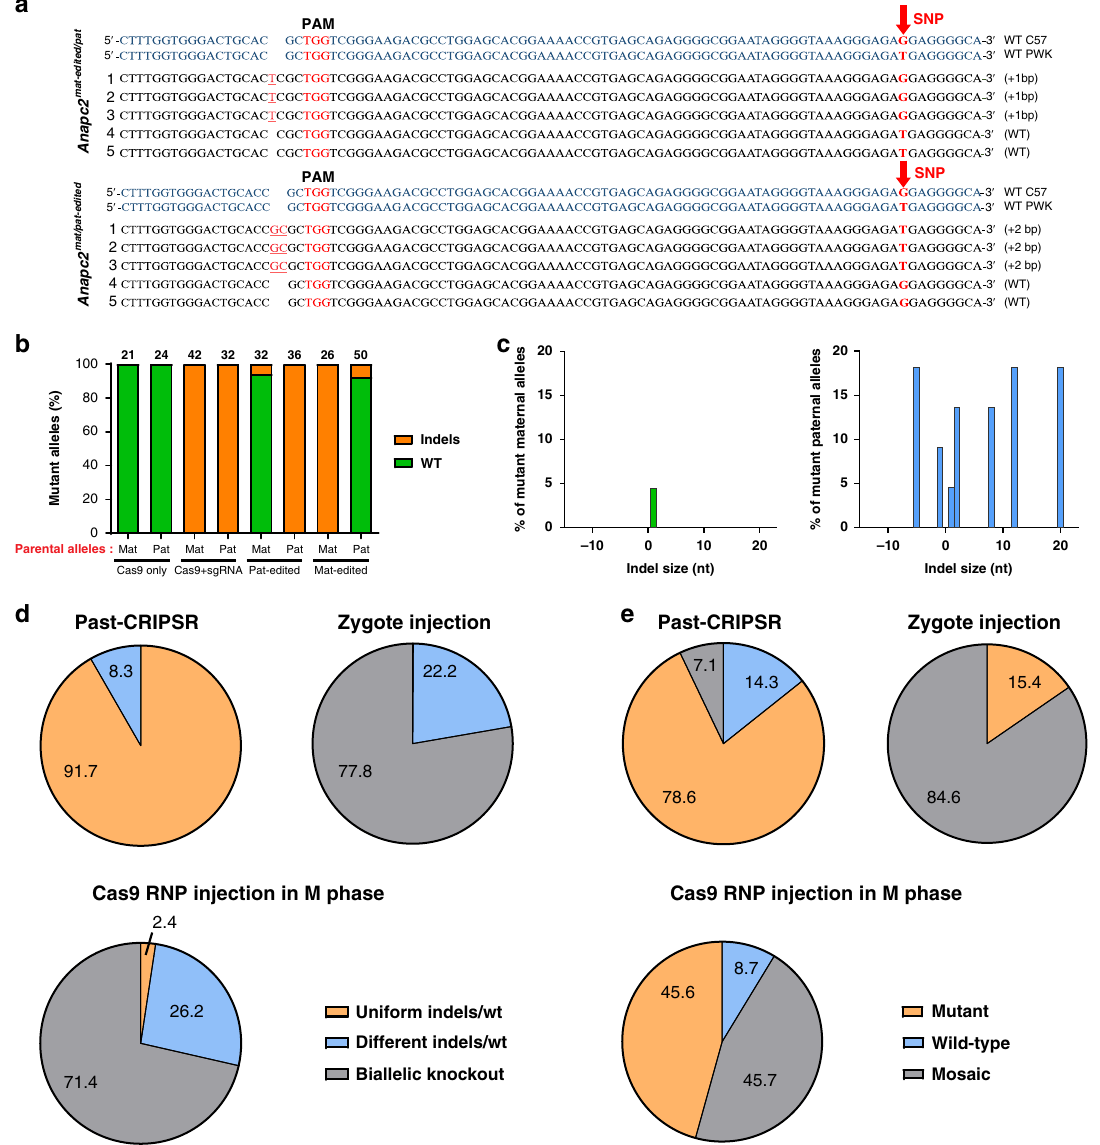
Fig. 2 Functional assessments for Past-CRISPR methods. a Sequence of alleles present in individual Anapc2 mat-edited/pat and Anapc2 mat/pat-edited hybrid embryos constructed from C57BL/6J oocytes and PWK sperm. The SNP site between C57BL/6J and PWK is indicated by red arrows. Number, a total of 15 embryos counted. b On-target allele analysis of TA clone sequencing of blastocysts treated with Cas9-only, Cas9 + sgRNA, Pat-edited, and Mat-edited. The number above each column represents the total clones analyzed. c Indel pro fi les from embryos who were performed paternal allele edited by Past-CRISPR. Anapc2 maternal alleles (left) and paternal alleles (right) are plotted separately. Minus numbers represent deletions, and plus numbers represent insertions. Statistics for sequences without indels and with single-base substitution mutation indels are not shown in this chart. d Pie charts show the percentage of the three predicted targeting genotypes in the Past-CRISPR- edited embryos (upleft), traditional zygote injection embryos (upright) and Cas9 RNP injection in M-phase embryos (downleft). Numbers in pie charts represent the percentage of embryos. All the tested embryos were from at least six independent experiments. e Pie charts showing percentages of different genotypes of all embryos treated with Past-CRISPR (upleft), traditional zygote injection methods (upright) and Cas9 RNP injection in M-phase (downleft). Numbers in pie charts represent the percentage of embryos. All the tested embryos were from at least three independent